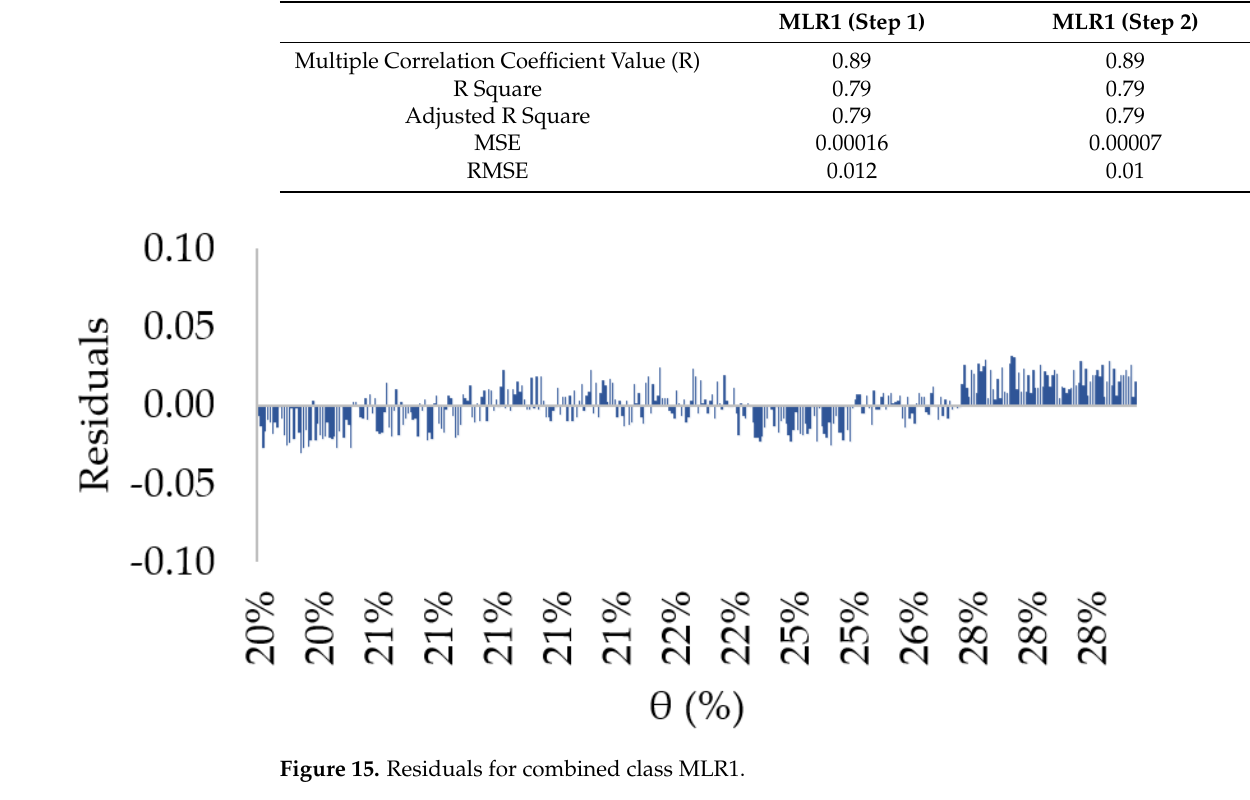
Table 7. MLR Model Parameters *.